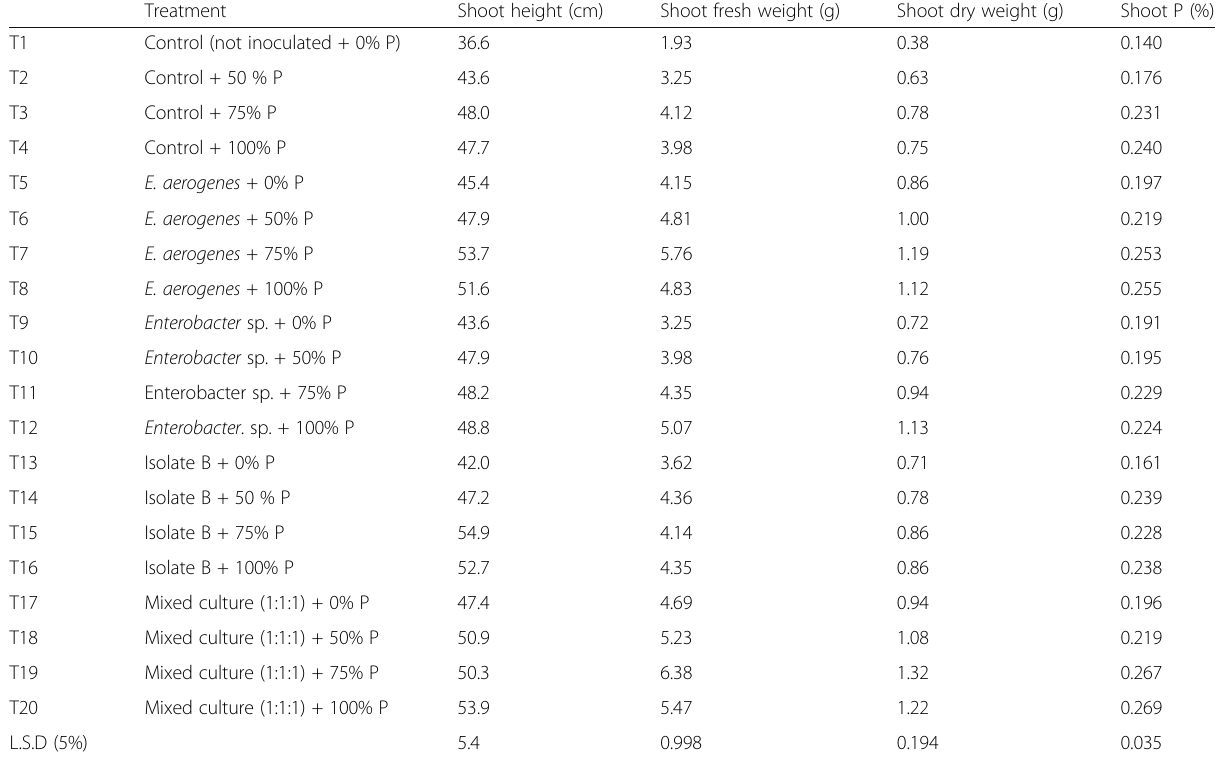
Table 3 Interaction effect (bacterial strain × phosphorus fertilizer %) on shoot growth